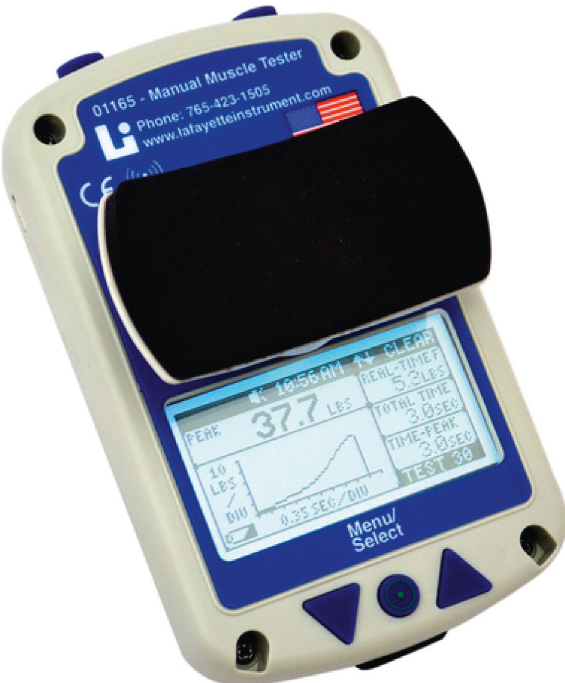
Figure 1: Nicholas manual muscle